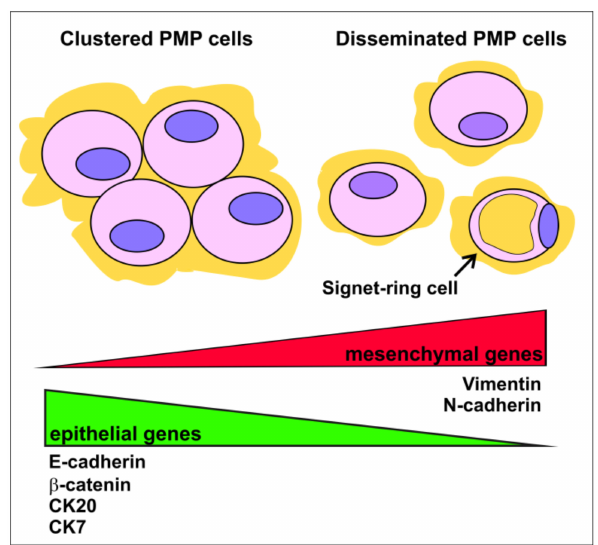
Figure 3. EMT profile in single and clustered PMP cells. Scattered cells in mucin pools are characterized by a more mesenchymal state (red triangle), whereas cell clusters show a more epithelial profile (green triangle). Single cells are frequently associated with a more aggressive clinical behavior, and more frequently show signet-ring morphology, indicated by the arrow. CK: